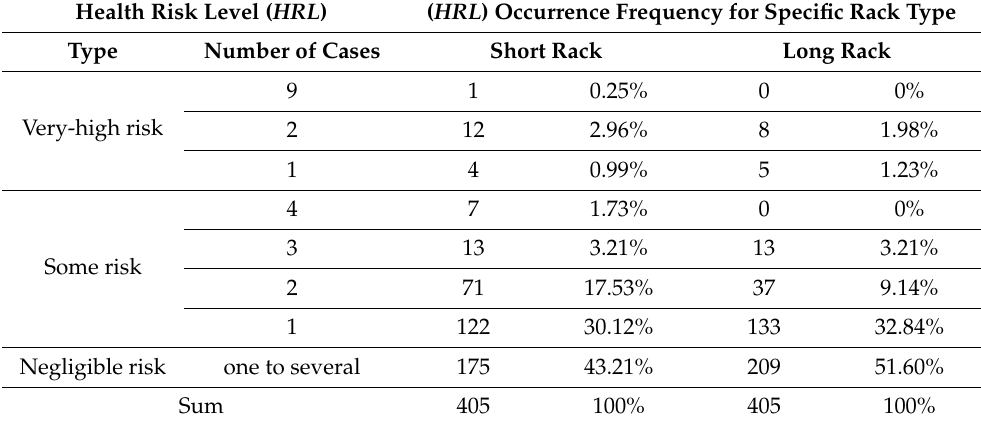
Table 5. Frequency of occurrence of a specific health risk